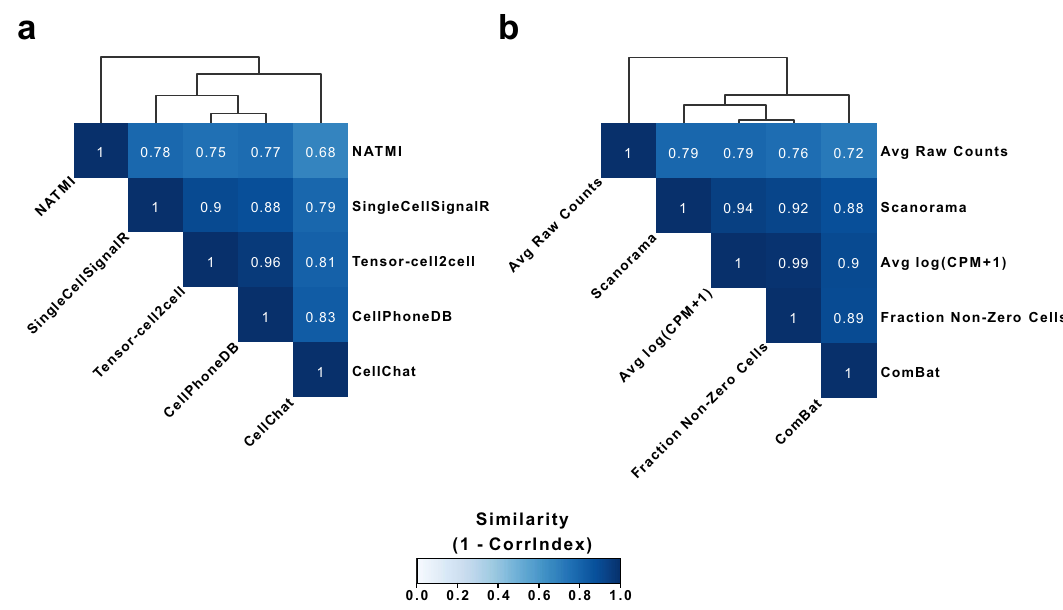
Fig. 3 Comparison of tensor decompositions resulting from varying input values. The similarity of tensor decompositions performed on 4D- communication tensors constructed from the single-cell dataset of BALF in patients with varying severities. For a given comparison, constructed tensors have the same elements in each dimension. a Similarity between tensor decompositions performed on 4D-communication tensors, each corresponding to communication scores computed from different tools for inferring cell – cell communication. The scoring functions correspond to those of CellChat 10 , CellPhoneDB 19 , NATMI 9 , SingleCellSignalR 20 and the built-in methods in Tensor-cell2cell. b Similarity between tensor decompositions performed on 4D- communication tensors, each modifying the gene expression values by different preprocessing methods (log(CPM + 1) and the fraction of non-zero cells 23 ) or batch-effect correction methods (Combat 24 and Scanorama 25 ), as well as using the raw counts. The communication scores in ( b ) were calculated as the mean expression between the partners in each LR pair, previously aggregating gene expression at the single-cell level into the cell-type level. In ( a , b ) similarity was measured as (1-CorrIndex), where the CorrIndex 21 is a distance metric for comparing different decompositions on tensors containing the same indices and its values range from 0 to 1 (more similar to more dissimilar). Assessed methods were hierarchically clustered by the similarities of their tensor decompositions. Similarity values are provided in the Source Data fi